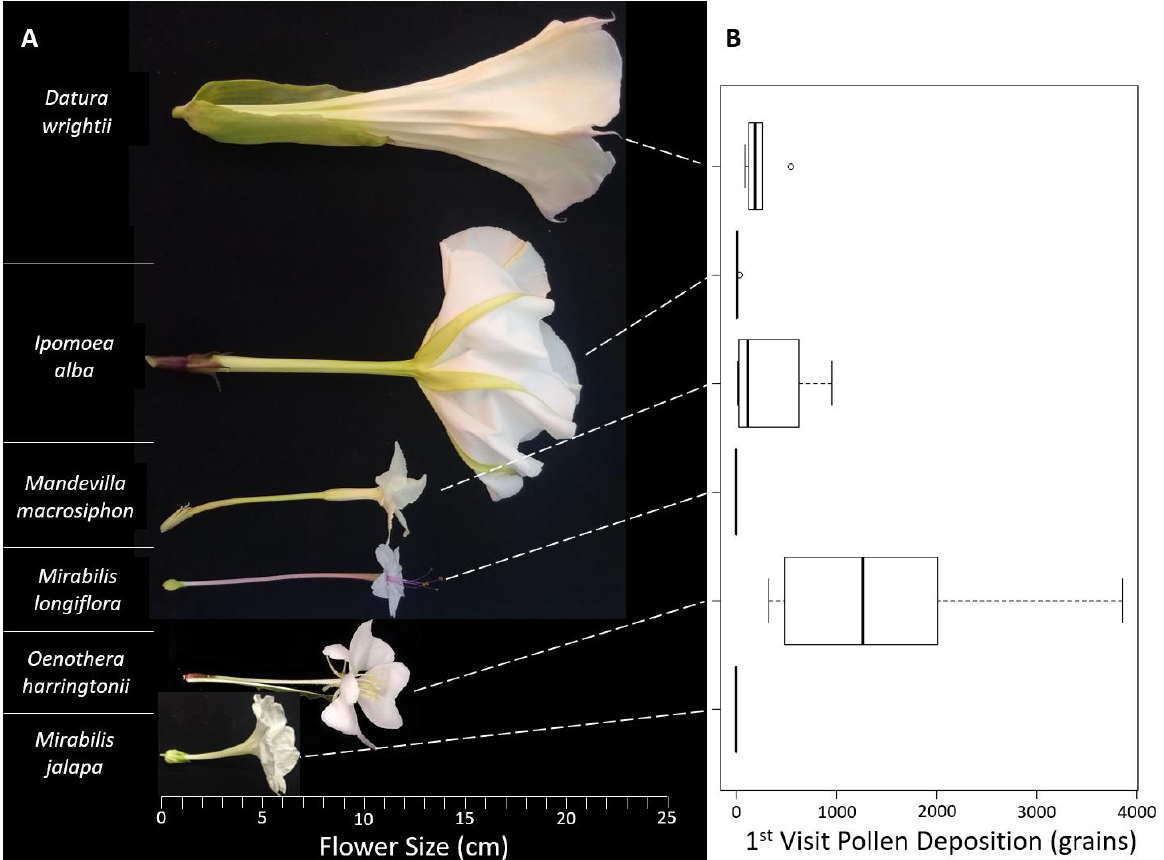
Figure 2. First-visit accumulation of pollen grains on the proboscises of Manduca sexta after visiting one of six plant species. A : Plant species arranged from largest to smallest based on nectar tube depth. B : Box-plot of pollen grain numbers present on moth proboscises after a single visit. The heavy bar represents the mean and the box bounds the 1 st and 3 rd quartiles. The yellow line on the scale bar represents the mean length of M. sexta proboscises in this study (mean ± SEM = 6.65 ± 0.74cm).